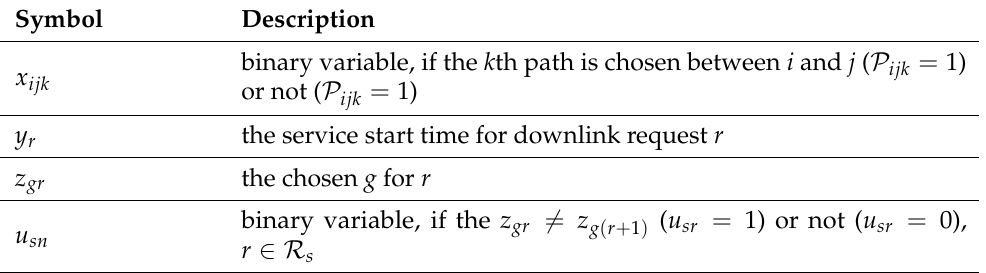
Table 2. Decision